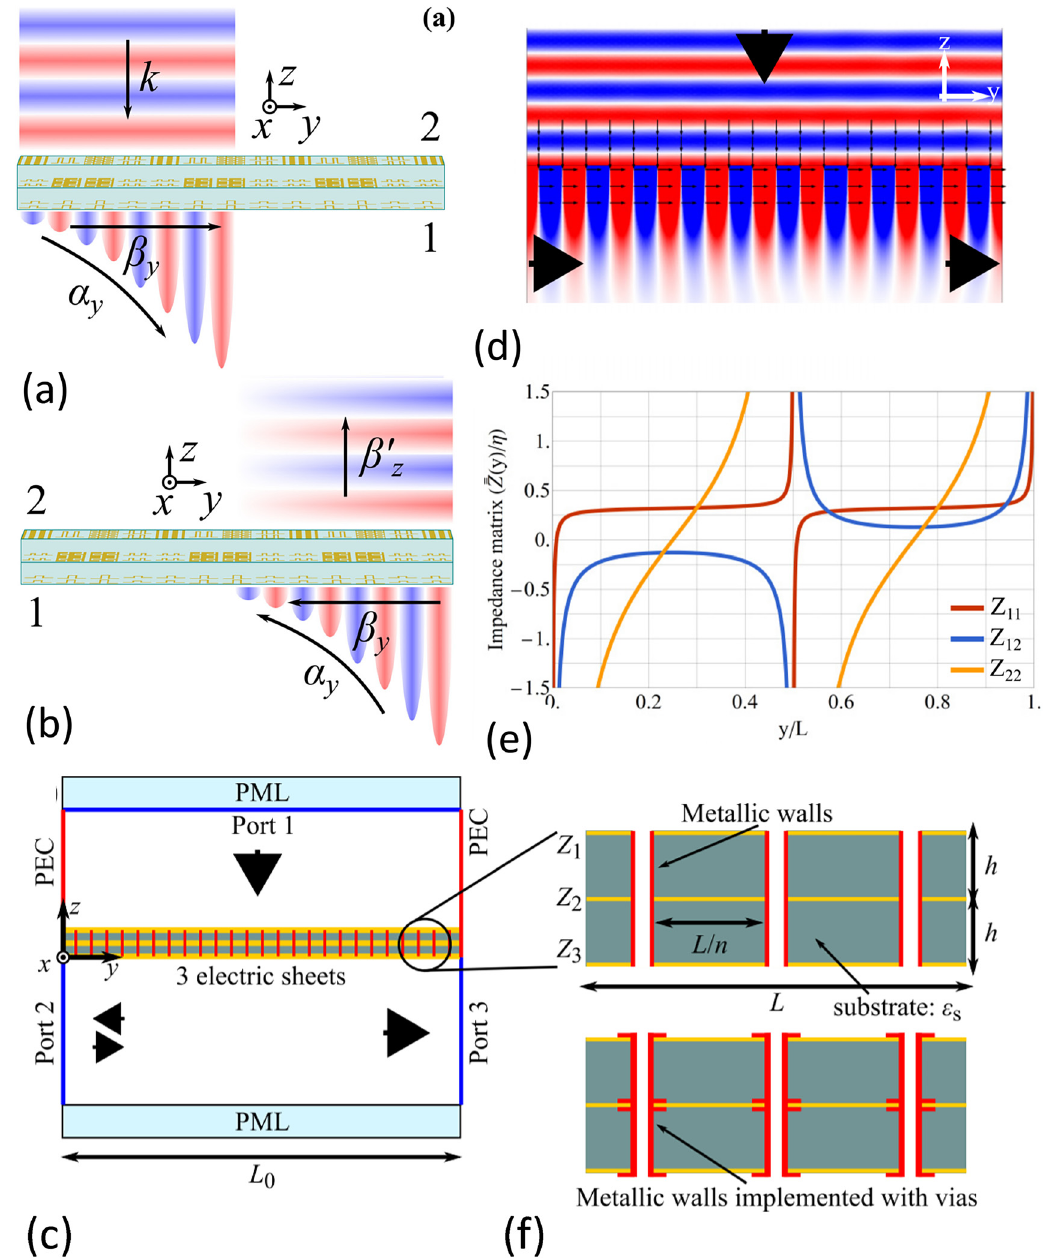
Figure 21: (Reprinted with permission from Ref. [50]). (a) Schematics of a metasurface converting a normally incident plane wave into a transmittedsurfacewavewith thepropagationconstant β andthegrowthrate α y . (b)Schematics of a metasurfaceconvertinga surfacewave y into an inhomogeneous plane wave propagating in the normal direction with the propagation constant β ′ . (c) Schematic of the COMSOL z models used for simulating the conversion with asymmetric three-layer structure. Port 1 launches the normally incident plane wave. Port 2 eitherlaunchesoracceptsthesurfacewave.Port3onlyacceptstheexcitedsurfacewave.(d)Snapshotofthemagnetic fi eldforametasurface with 10 periods, the growth rate is α y = 0 . 001 k with Port 2 on. The arrows depict the directions of power fl ow density. The metasurface is = 1 . 05 k .(e)Imaginarypartof representedbyanomega-bianisotropiccombinedsheetandpropagationconstantofthesurfacewaveequals β y theimpedancematrixasfunctionsofthe y -coordinate.(f)Zoomingofthethree-layermetasurfacewithmetallicwalls(implementedwithviasin upper) separating individual unit cells, n is the number of unit cells per super cell, Z i ( i = 1, 2, 3) is the electric surface impedance of the corresponding